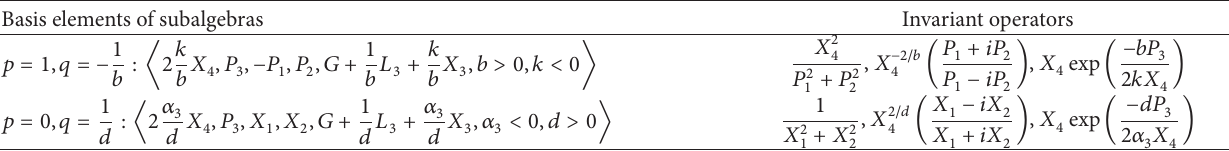
Table 23: Invariant operators of subalgebras of the type 𝐴 𝑝𝑞 5,16